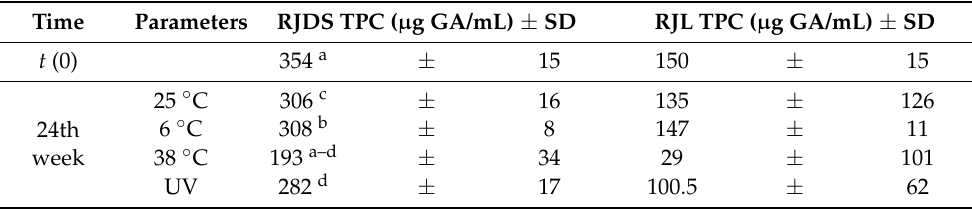
Table 1. Stability test TPC: Total Phenolic Compounds ( ± SD), of RJDS and RJL.